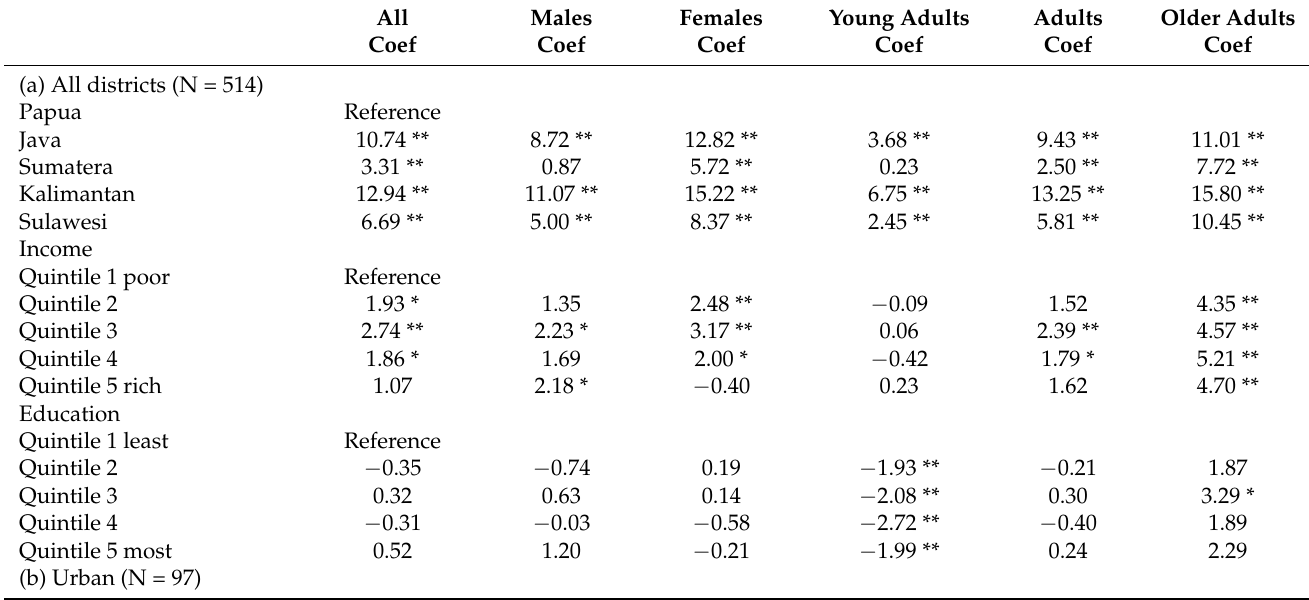
Table A4. Regression outputs for geographic and socioeconomic disparity in